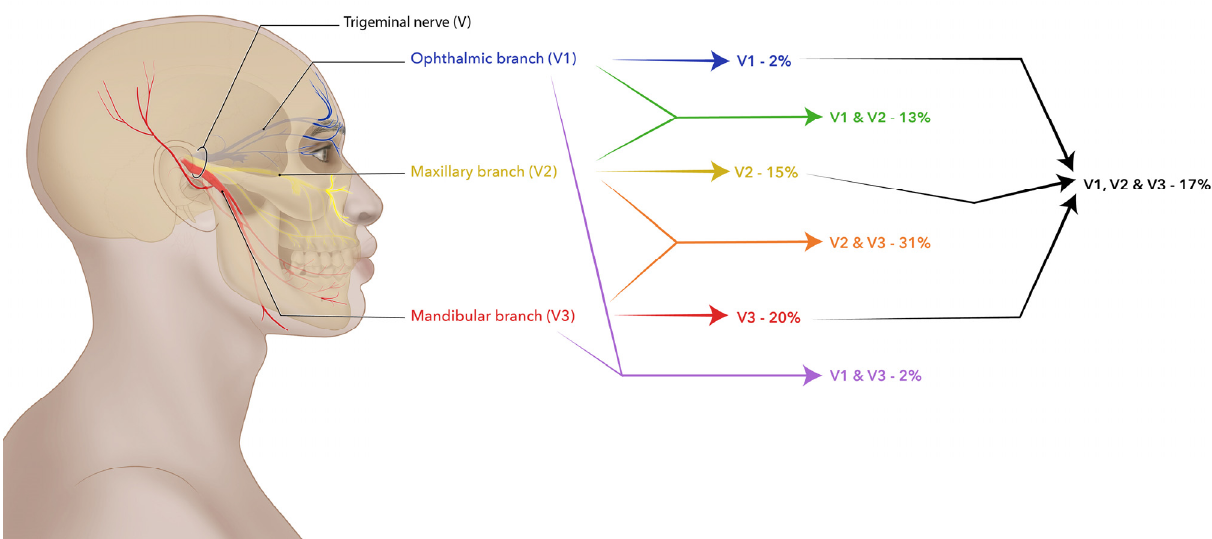
Figure 1. The prevalence of pain in the distribution of the different divisions of the trigeminal nerve.